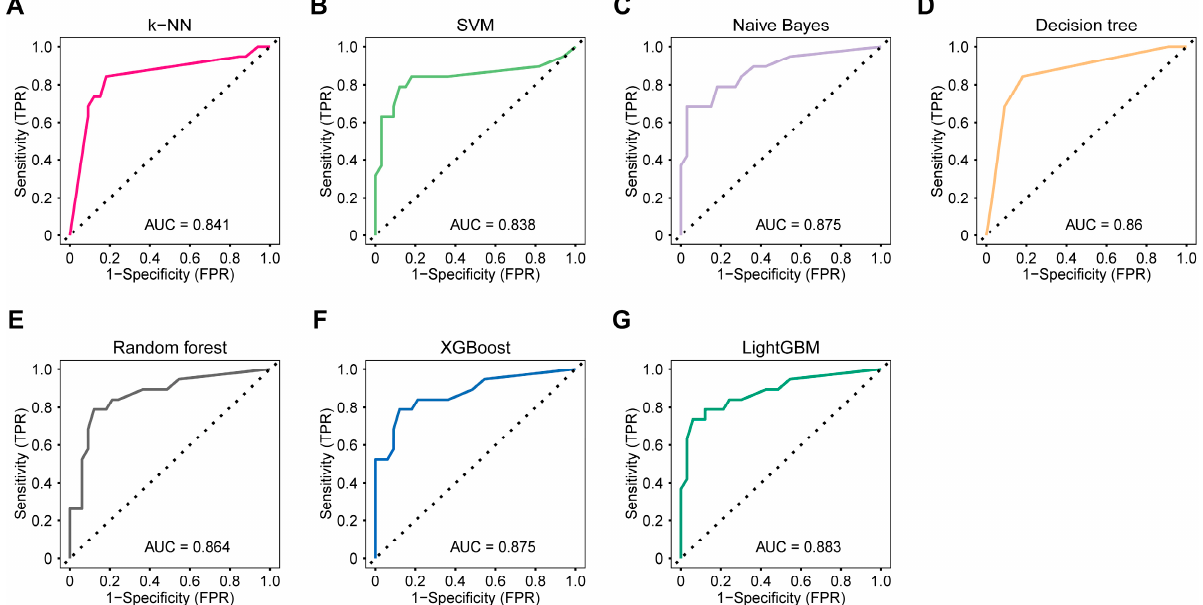
Figure 4. Comparison of the diagnostic performance of seven miRNA pair-based machine learning models. ROC curves measuring the performance of the models for predicting COPD patients and normal controls using ( A ) k-NN, ( B ) SVM, ( C ) Naive Bayes, ( D ) decision tree, ( E ) random forest, ( F ) XGBoost, and ( G ) LightGBM algorithms.